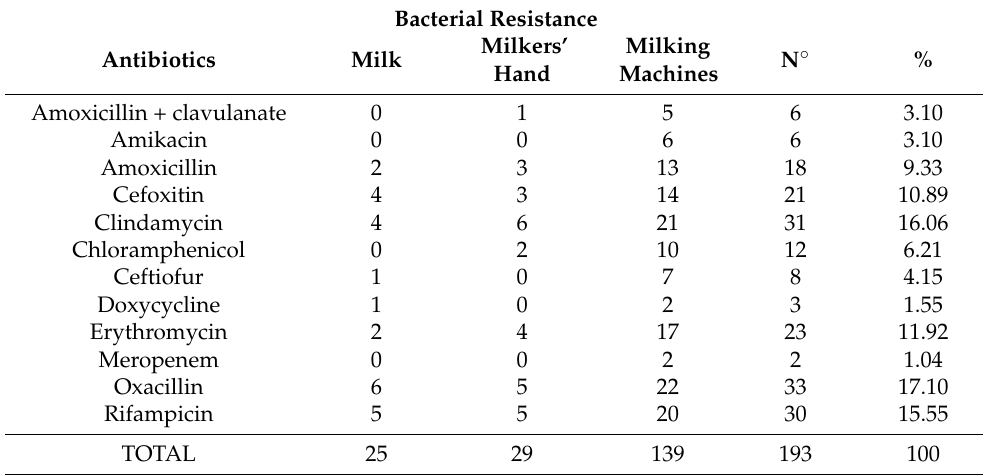
Table 4. Resistance profile of enterobacteria isolated from milk samples, hand swabs from milkers and milking machines, from the municipality of Boa Esperança, Tapejara and Juranda, northwest of Paran á State, Brazil, May–June 2022.